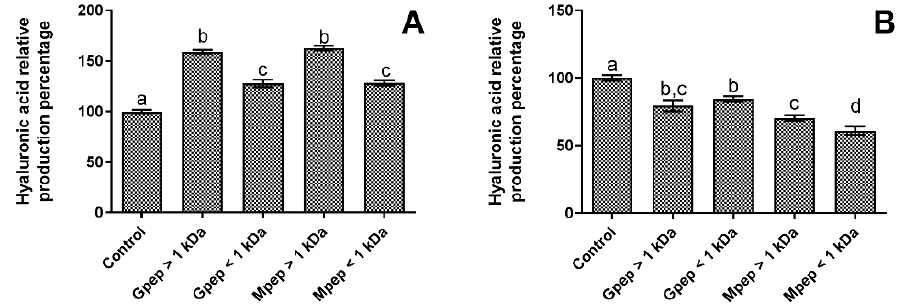
Figure 5. Hyaluronic acid relative percentage of production in the presence of different peptide fractions relative to the basal level (control). ( A ) HDFa; ( B ) HaCat. Different letters represent the statistically significant differences ( p < 0.05) found between the samples tested in each setting.